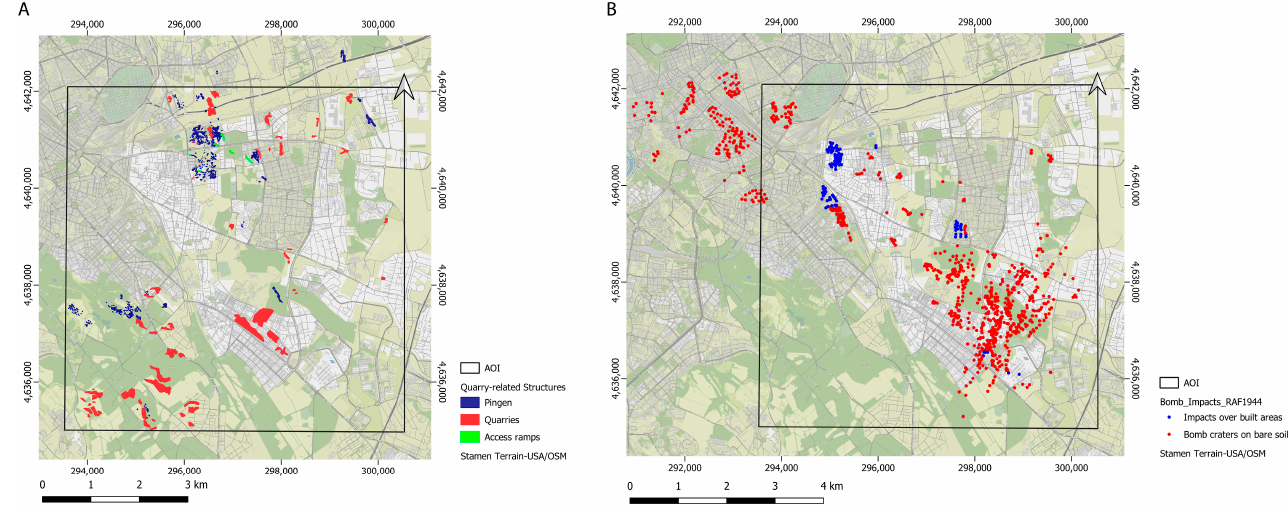
Figure 4. ( A ) Vectorization of quarry-related structures in the AOI from historical photographs; ( B ) The vector Bomb_Impacts_RAF_1944, categorized for the classes of bare soil and built areas.